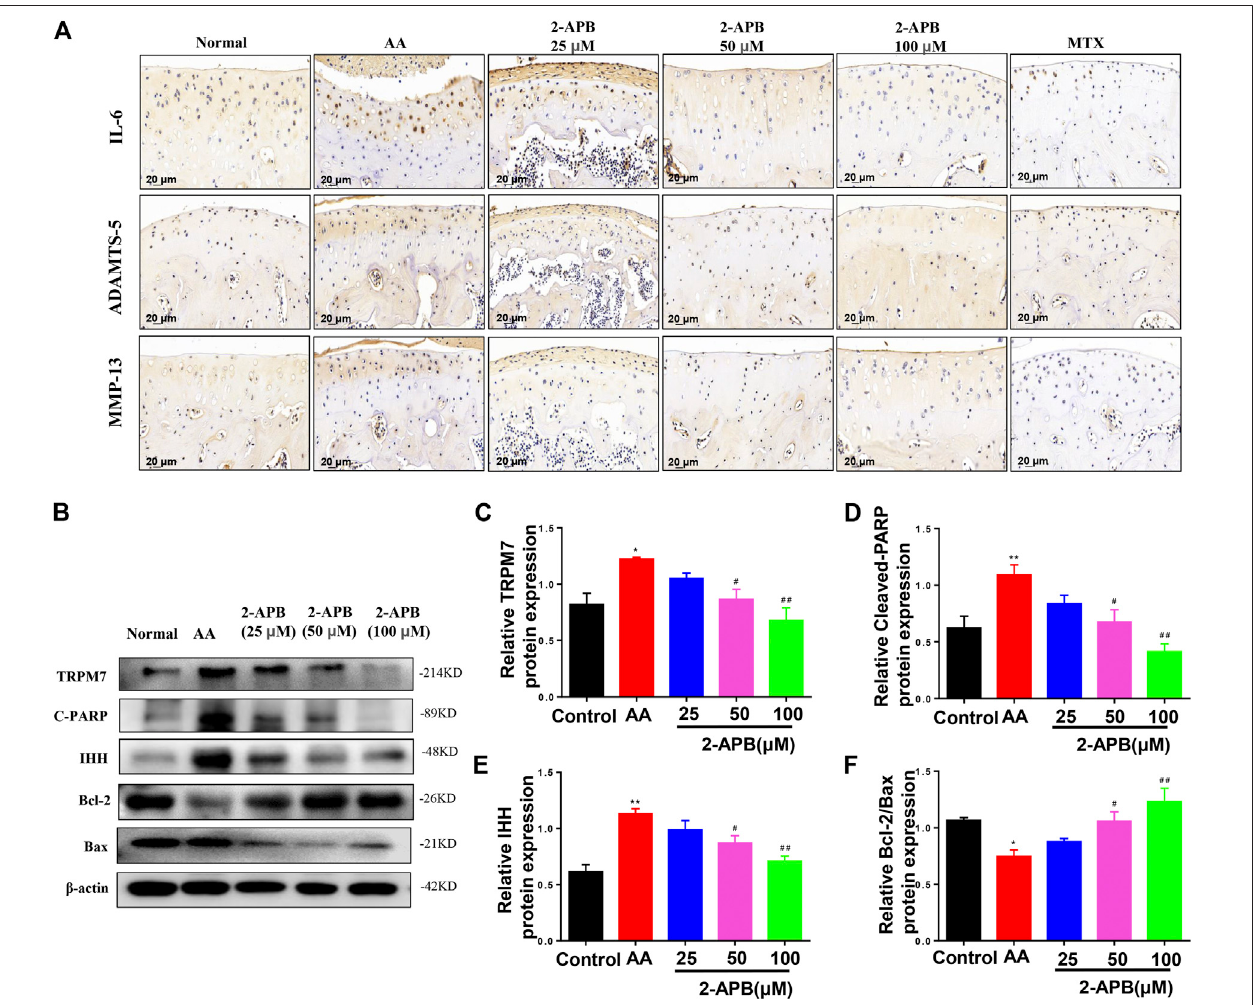
FIGURE 7 | 2-APB suppresses IL-6, ADAMTS-5 and MMP-13 protein expression in AA rat articular cartilage through inhibiting IHH expression (A) Immunohistochemical analysis of2-APB on expression ofIL-6, ADAMTS-5 and MMP-13 in AArats (B – F) Western blotanalysisof 2-APB regulationof TRPM7, IHH and cleaved PARP expression and Bcl-2/Bax ratio in articular cartilage of AA rats. Values are presented as mean ± SEM. n (cid:2) 8, * p < 0.05, ** p < 0.01, compared with control group; # p < 0.05, ## p < 0.01, compared with AA group.